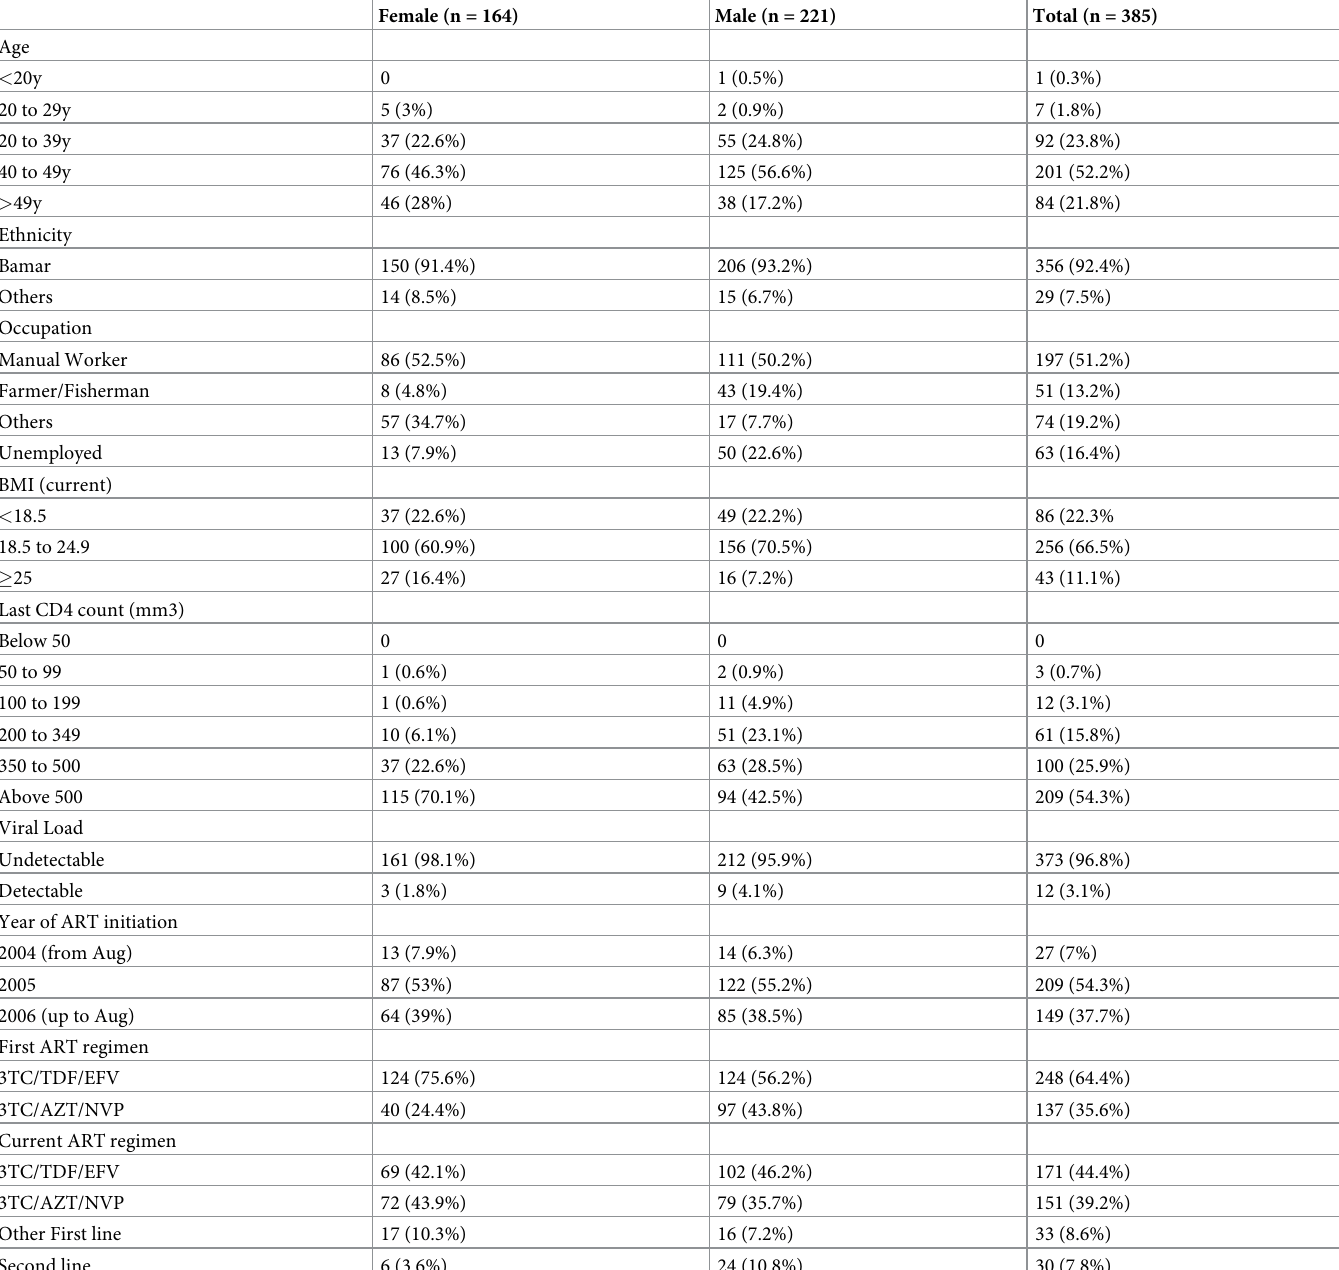
Table 3. Characteristics of patients who were included in the survey distributed by